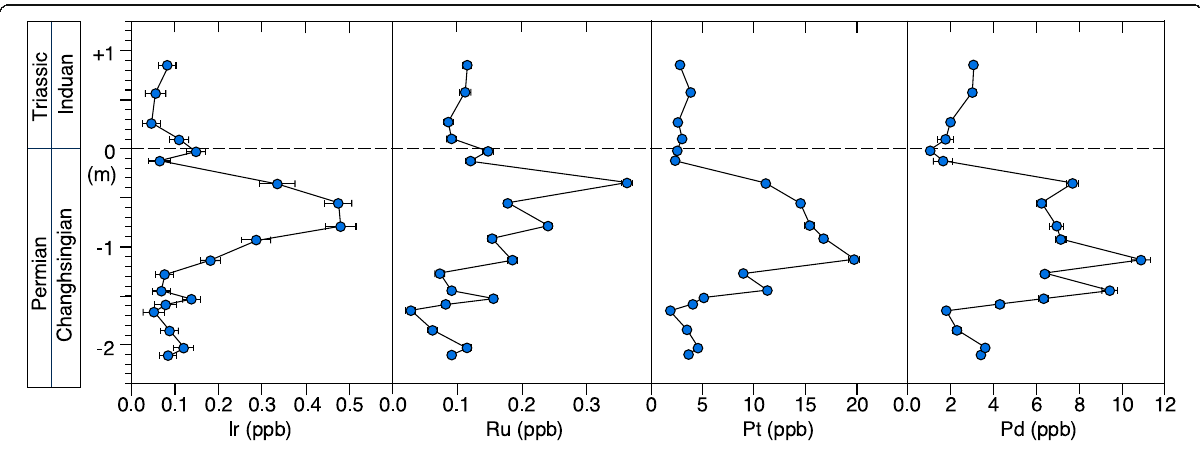
Fig. 4 Stratigraphic profiles of PGE contents of bedded cherts of the Waidani section. See Table 2 for data